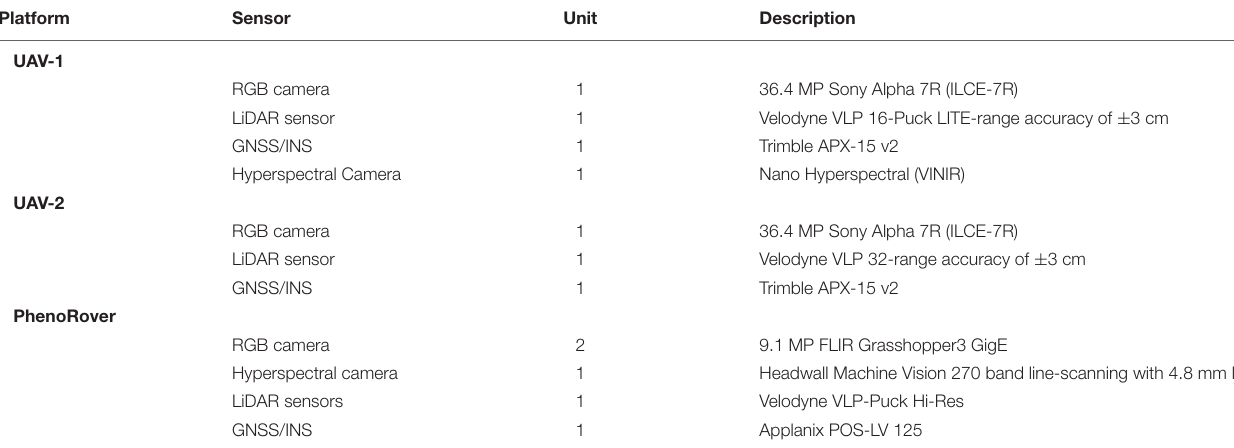
TABLE 2 | Platforms and mounted sensors specification in 2020. Platform